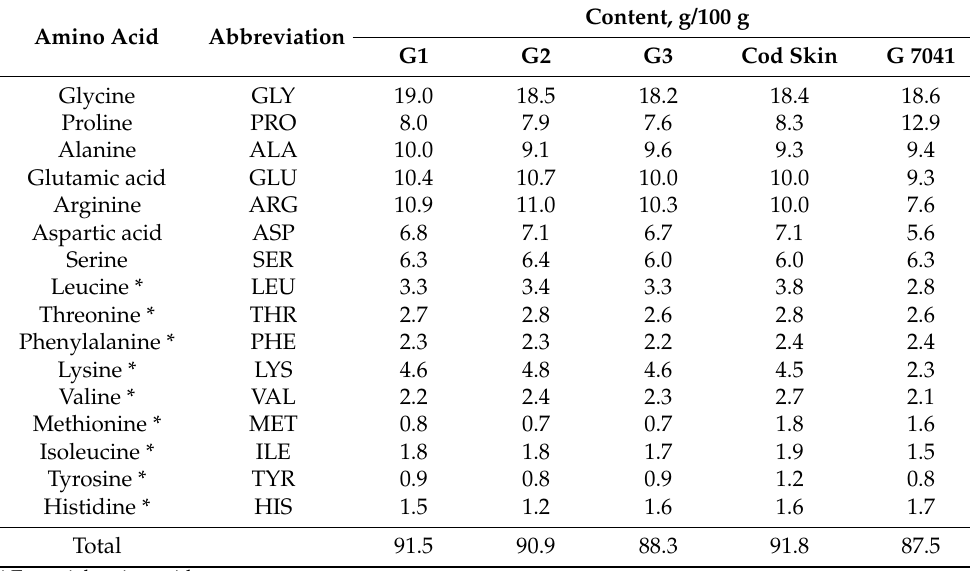
Table 3. Amino acid compositions of gelatin samples.